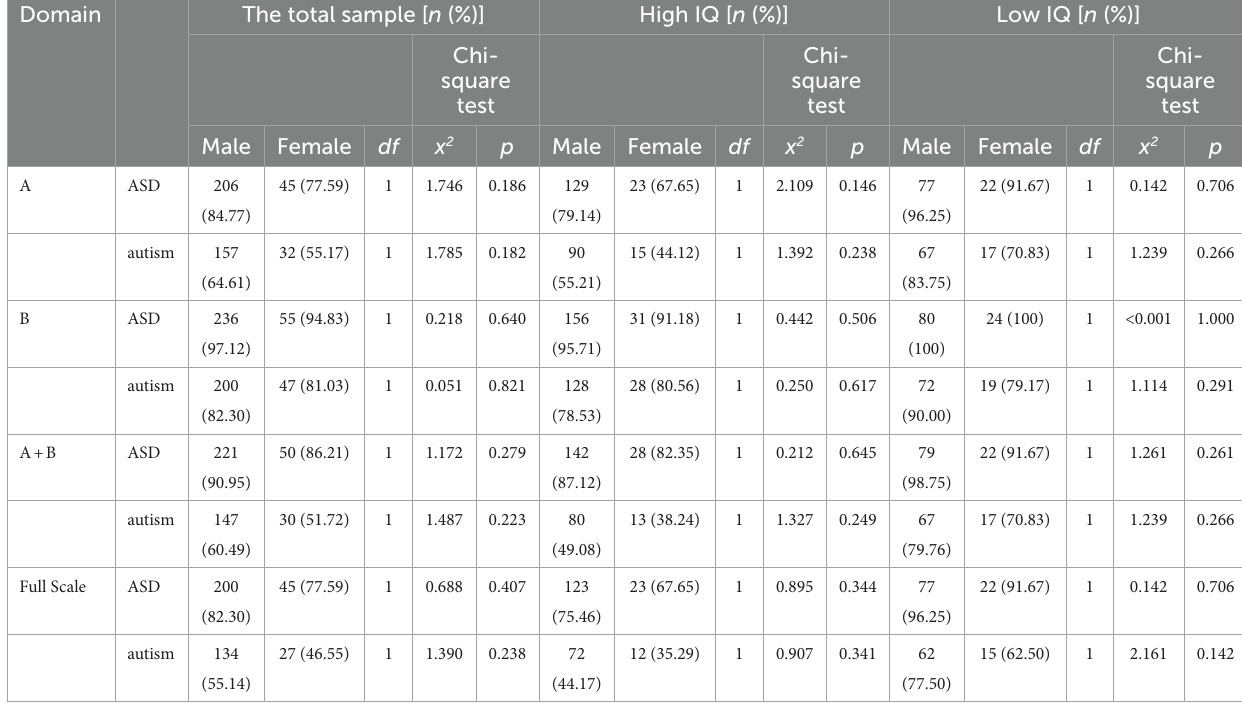
TABLE 4 Autism or ASD diagnosis compliance rate in ADOS. Domain